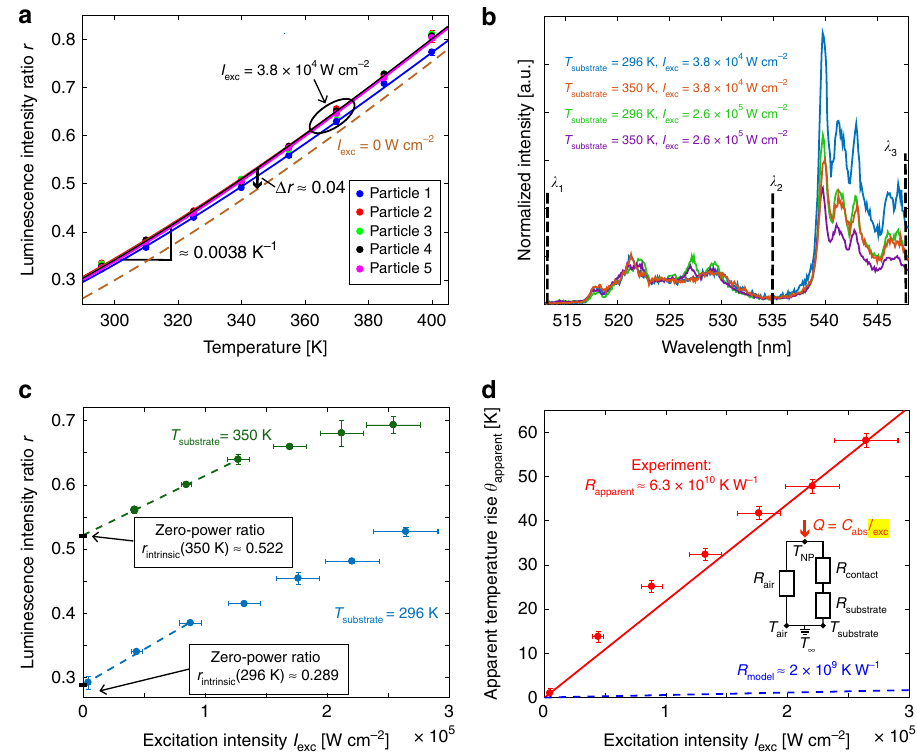
Fig. 2 Ratiometric thermometry and apparent self-heating. a Luminescence intensity ratio calibration for fi ve individual nanoparticles on a borosilicate glass substrate. The solid lines are fi ts to Eq. (1). The dashed orange line represents the r intrinsic ( T ) curve obtained by shifting the best fi t r (3.8 × 10 4 W cm − 2 , T ) curve downward by Δ r ≈ 0.04 to account for fi nite-excitation intensity effects. b Luminescence spectra at different T substrate and I exc . The increases in r with T I substrate and exc are both driven by broad changes in the relative emission intensity from c The luminescence intensity ratio increases almost linearly with excitation intensity. The zero-power ratios r intrinsic (296 K) and r intrinsic (350 K) can be determined by extrapolating r ( I exc , 296 K) and r ( I exc , 350 K) to zero power, respectively, here using the bottom three points. Error bars in r represent the standard deviation of two consecutive measurements, while error bars in I exc are ±10% to account for decreased laser stability and greater measurement uncertainty at higher I exc . d The results from the T substrate = 296 K data in c converted to an apparent temperature rise using the temperature calibration from a . The apparent thermal resistance of ~6.3 × 10 10 K W − 1 is directly proportional to the slope of the fi tted red line. This value is more than an order of magnitude higher than the 2 × 10 9 K W − 1 resistance predicted by our highly conservative thermal model (blue dashed line). Error bars in the apparent temperature rise account for both trial-to-trial variation and uncertainty due to the use of a batch calibration curve (see Supplementary Note 4 for